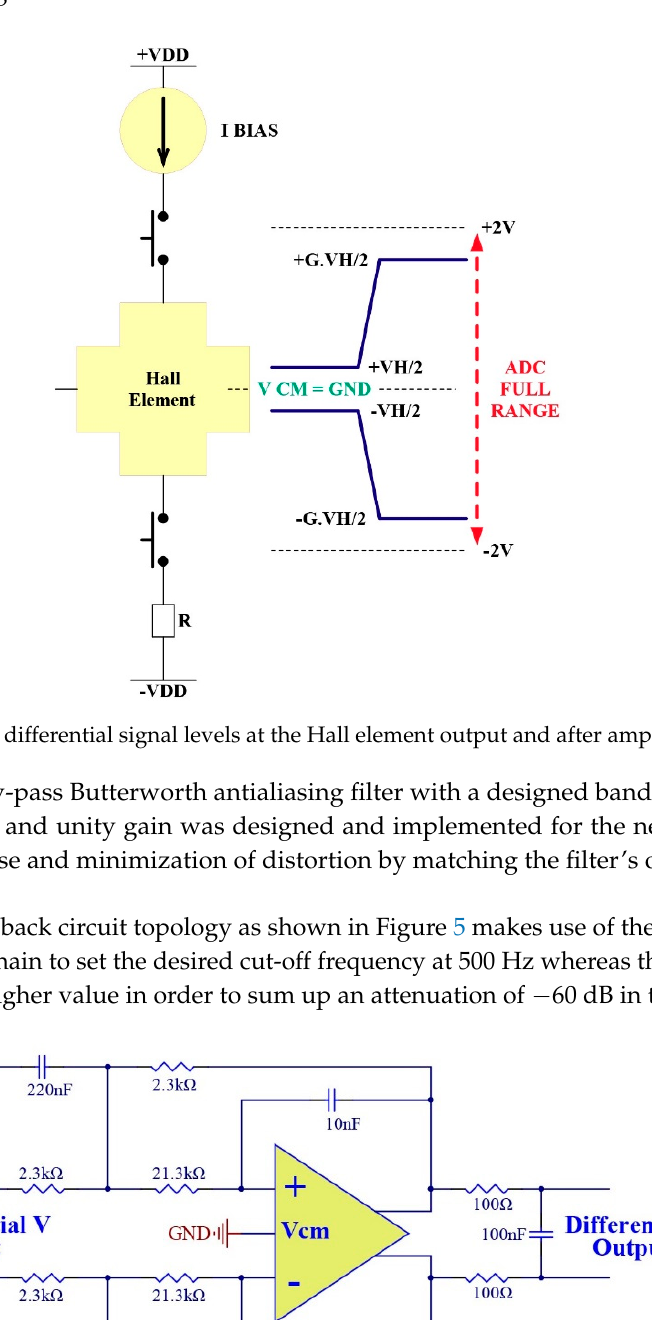
Figure 5. Third-order low-pass Butterworth differential antialiasing filter.